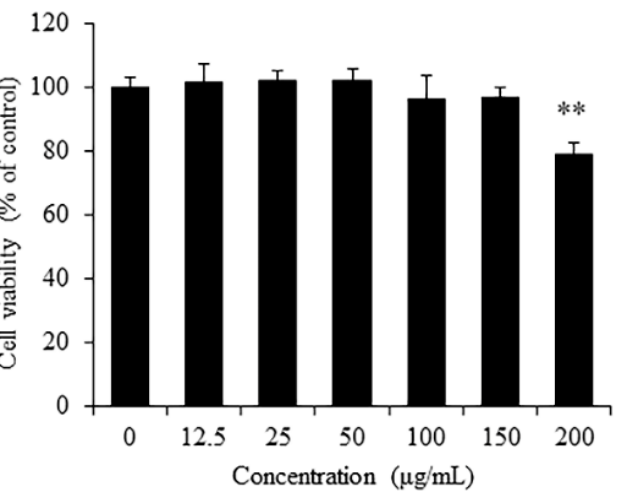
Figure 1. Cytotoxicity of RSO on RAW 264.7 cells. Cells were treated by RSO (0, 12.5, 25, 50, 100, 150, and 200 µ g/mL) for 24 h, n = 6. ** p < 0.01 vs control group.